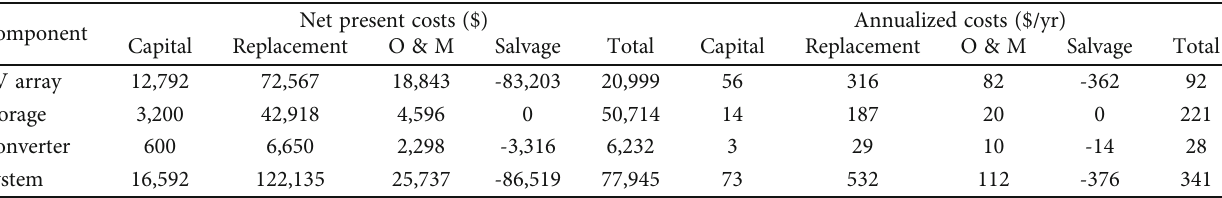
Table 6: Present worth and annualized value of all costs over 40 years.